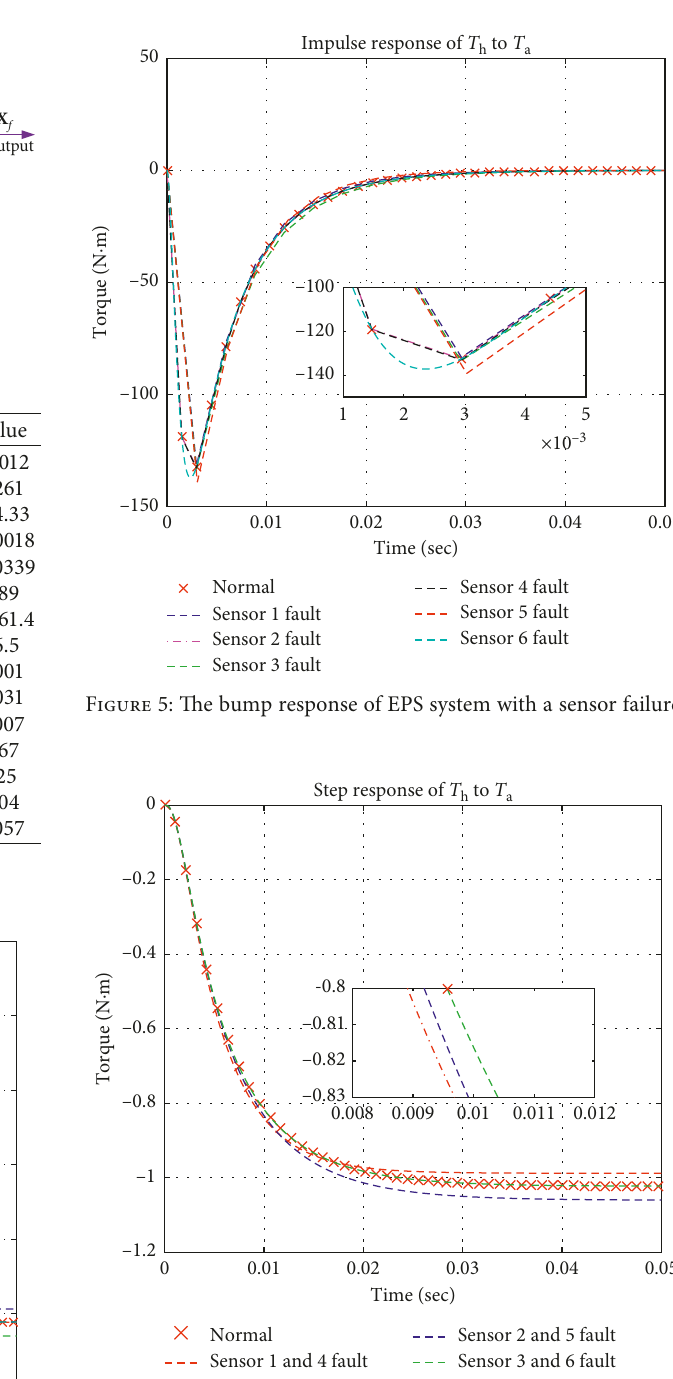
Figure 6: The step response of EPS system with two sensor